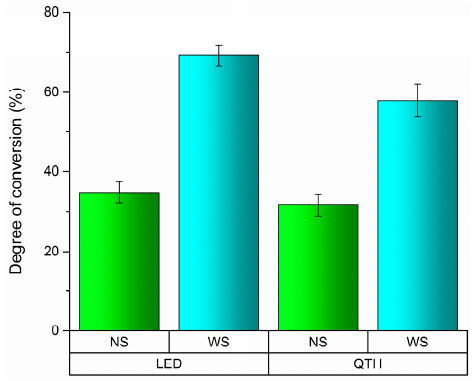
Figure 2. Degree of conversion for the interaction between bonding agents and the technique for the oxygen-inhibited layer (OIL) displacement.